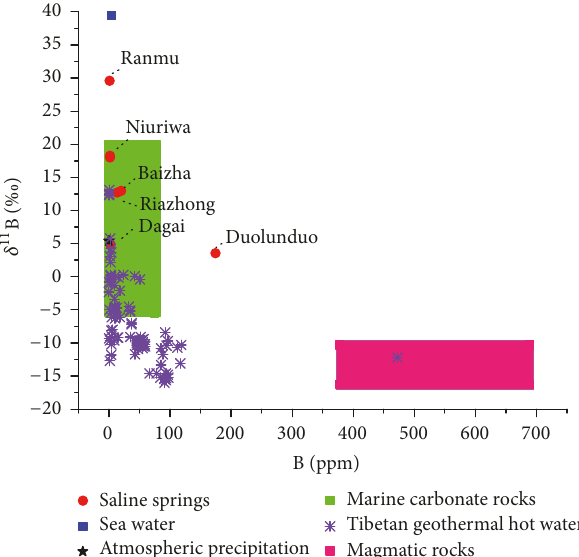
Figure 6: Relationship between 𝛿 11 B and B concentration in the saline springs of the Nangqen Basin. The green and pink shaded areas are the regions with boron geochemical characteristics of crustal marine carbonate rocks and magmatic rocks, respectively [10]. Data for Tibetan geothermal hot water is from